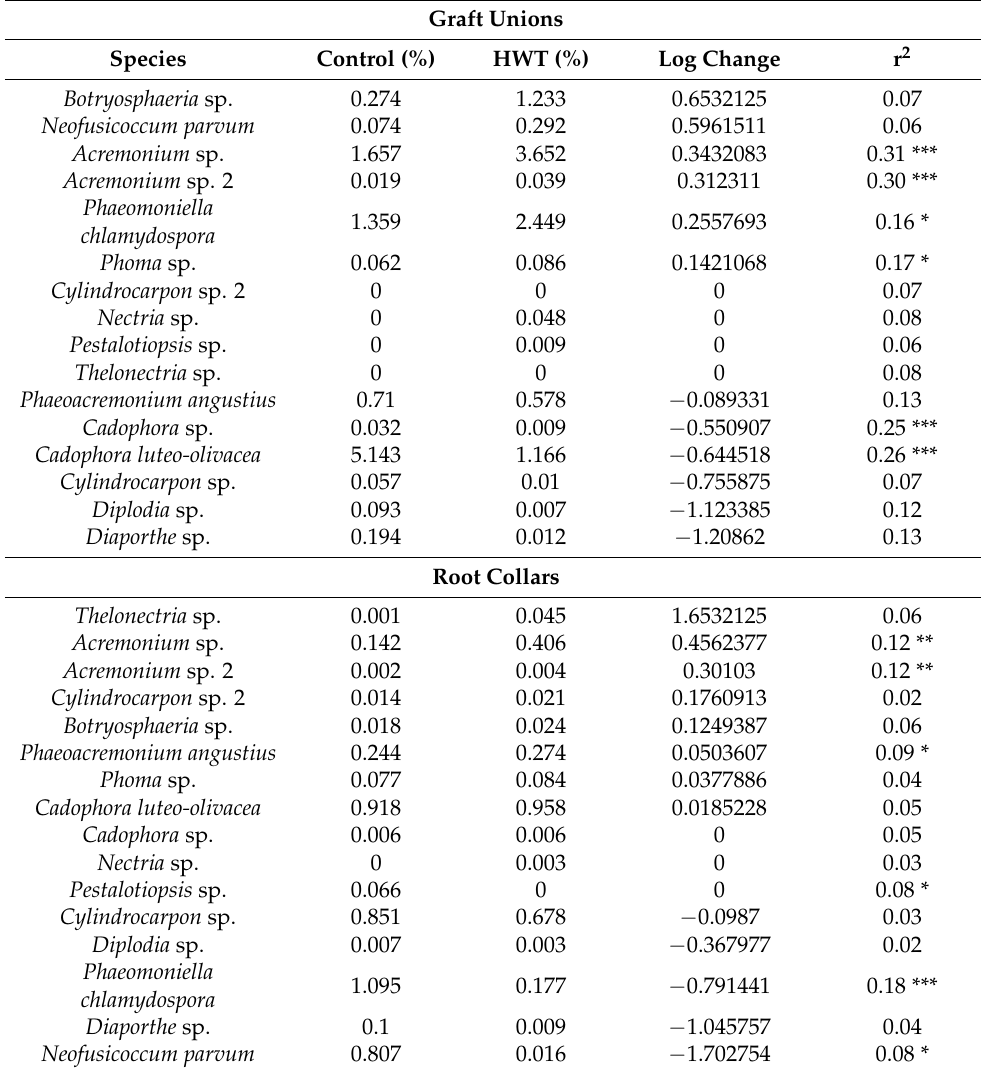
Table 4. Log change in the relative abundance (%) of GTD-related species in each tissue type between control and treated (HWT) plants. The significance of the difference between treatments is indicated for each tissue type (r 2 ). The annotation following the r 2 values indicates the significance level ( p -value): *** <0.001, ** <0.01, *